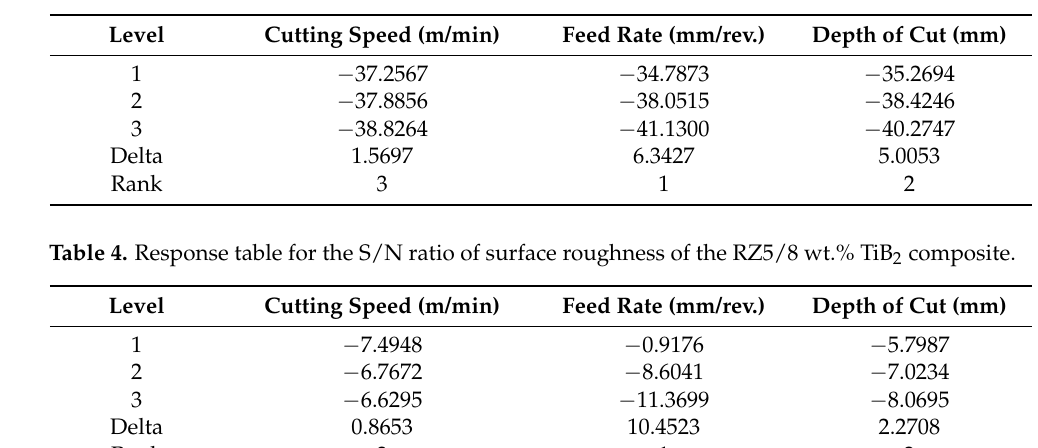
Table 3. Response table for the S/N ratio of cutting force of the RZ5/8 wt.% TiB 2 composite.